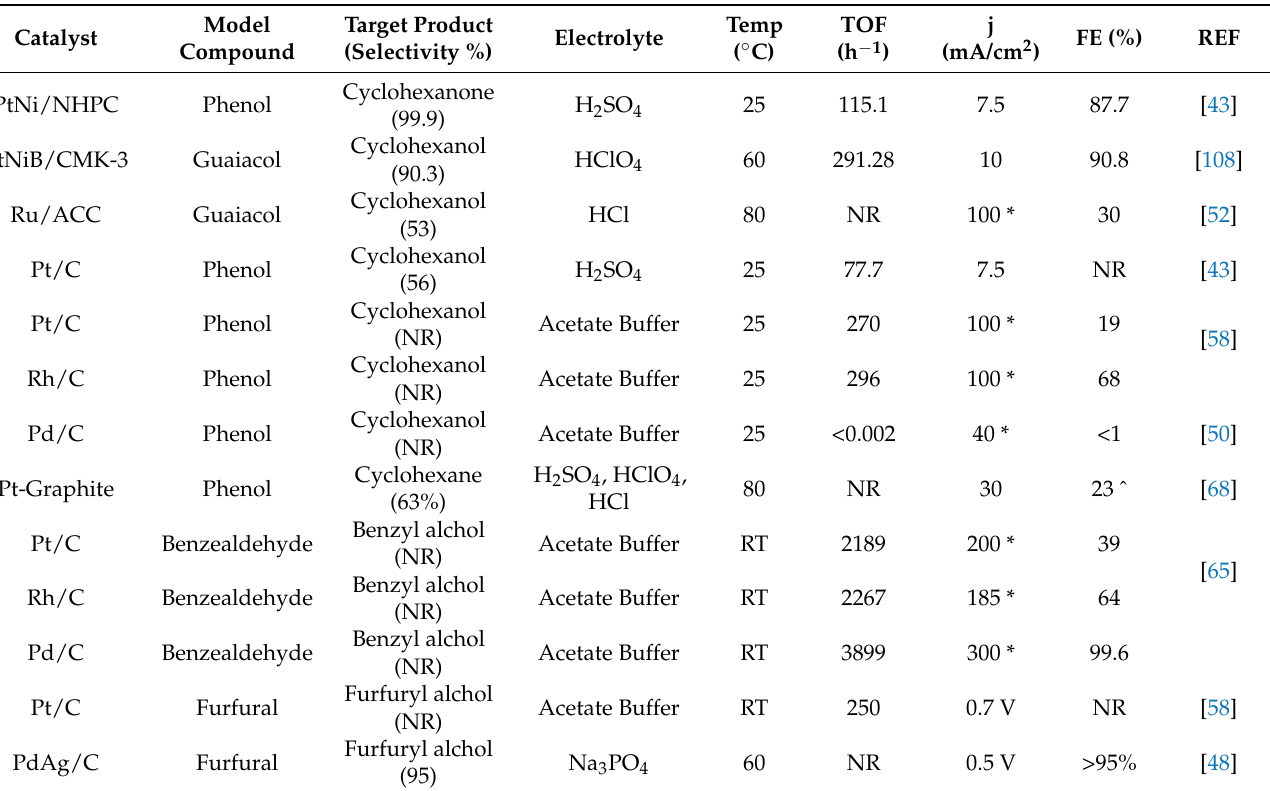
Table 1. Summary of the literature on the ECH of bio-oil model compounds with platinum group